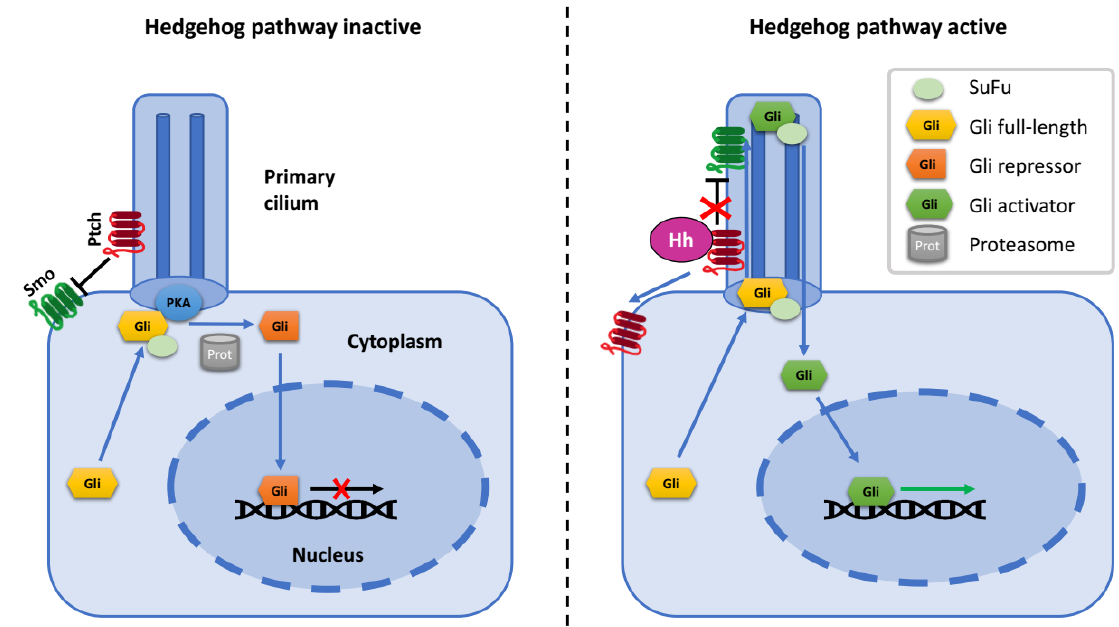
Figure 1. Schematic diagram of the hedgehog (Hh) pathway.